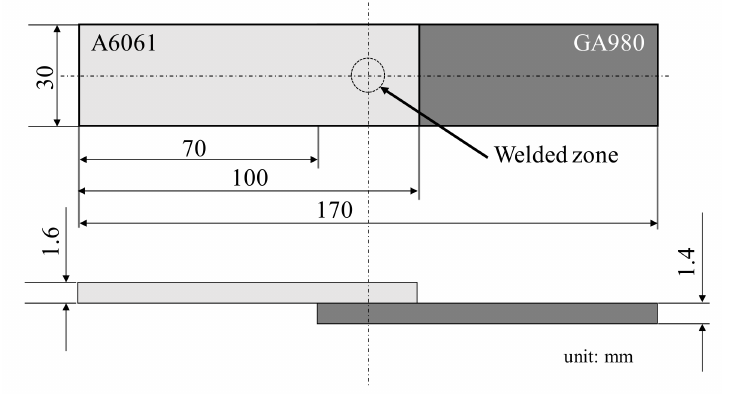
Figure 3. Shape and dimensions of the tensile shear specimen.